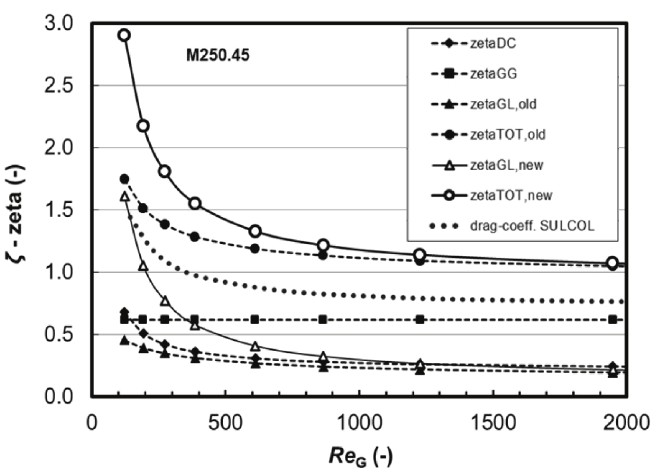
Fig. 6 – Individual and overall pressure loss coefficients for original (symbols with dashed lines) and extended DM (sym- bols with solid lines), and the corresponding drag coefficient curve of SULCOL (dotted line) for hypothetical base case and M250.45